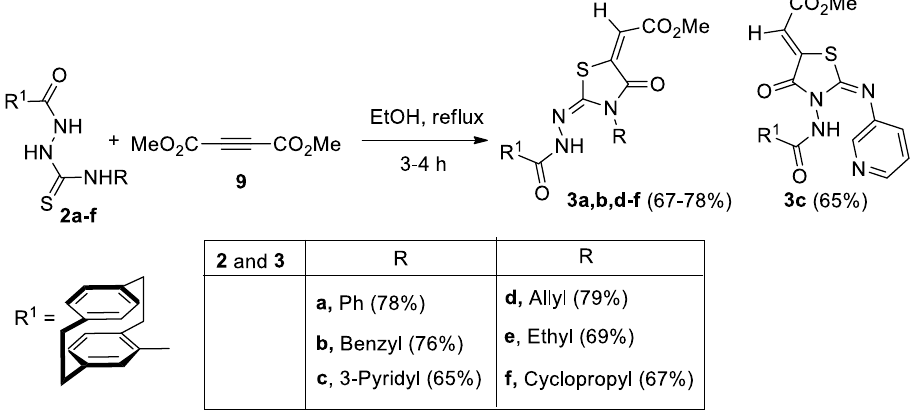
Scheme 4. Reaction of 2a – f with dimethyl acetylenedicarboxylate ( 9 ): synthesis of different regioisomers thiazolidines 3a,b,d – f and 3c.